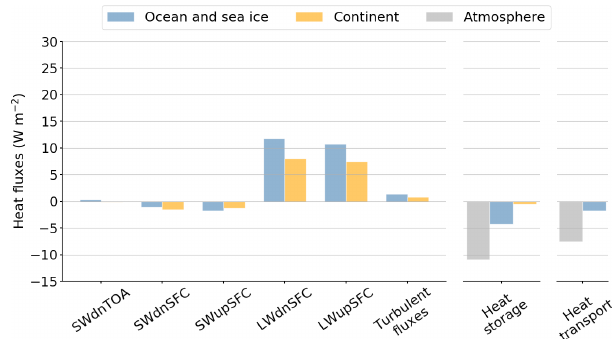
Figure 14. Same as Fig. 9 for